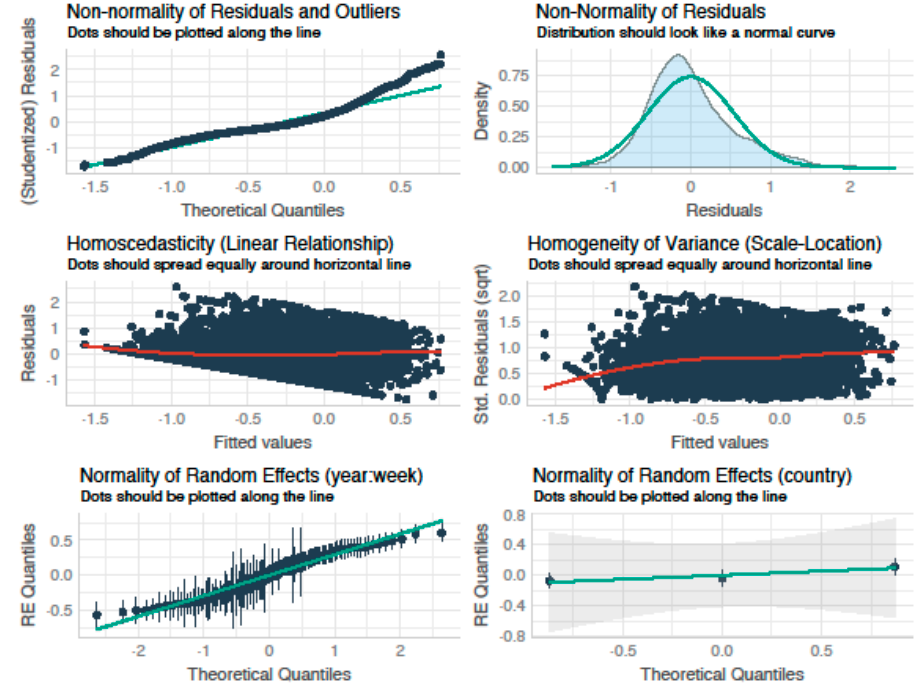
Figure A2. Model performance for the autumn migration period, obtained with the R package “performance” [78].